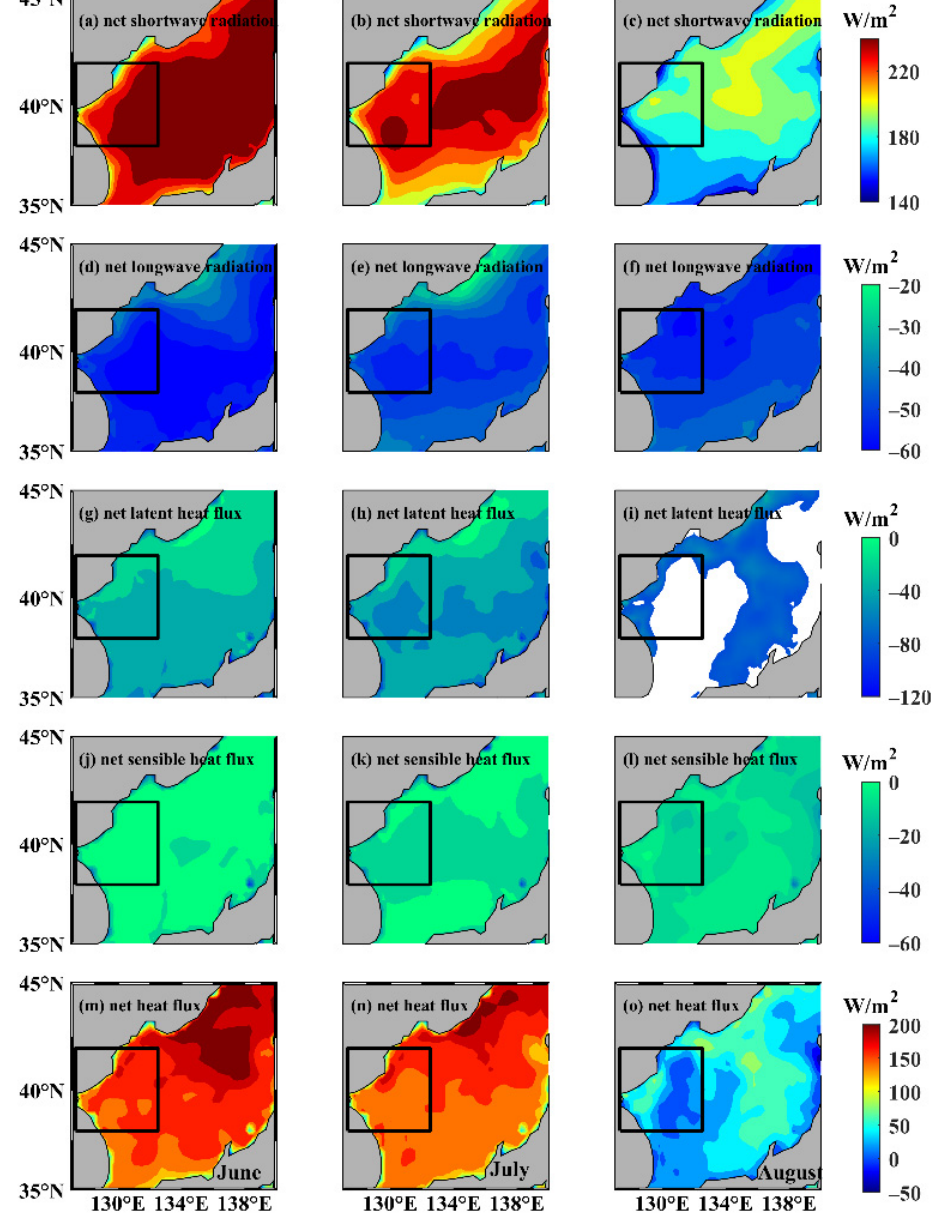
Figure 7. Spatial distribution of ( a – c ) net shortwave radiation, ( d – f ) net longwave radiation, ( g – i ) net surface latent heat flux, ( j – l ) net surface sensible heat flux, ( m – o ) net surface heat flux (units: W/m 2 , all fluxes are positive downward) from June to August